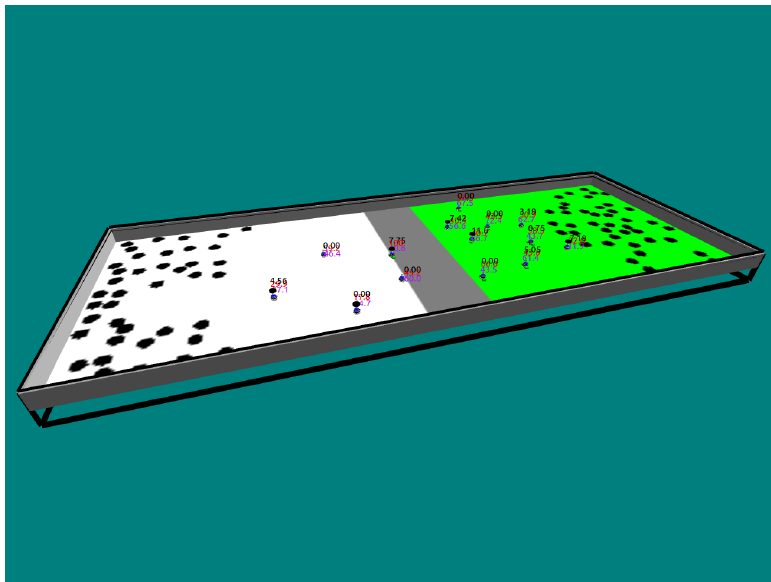
Figure 11. Environment used for all tests requiring terrain preference and categorisation of heterogeneous robots within the swarm.